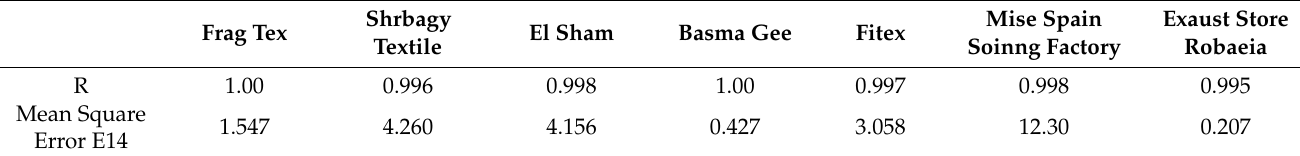
Table 8. The regression and mean square error of the seven case studies.